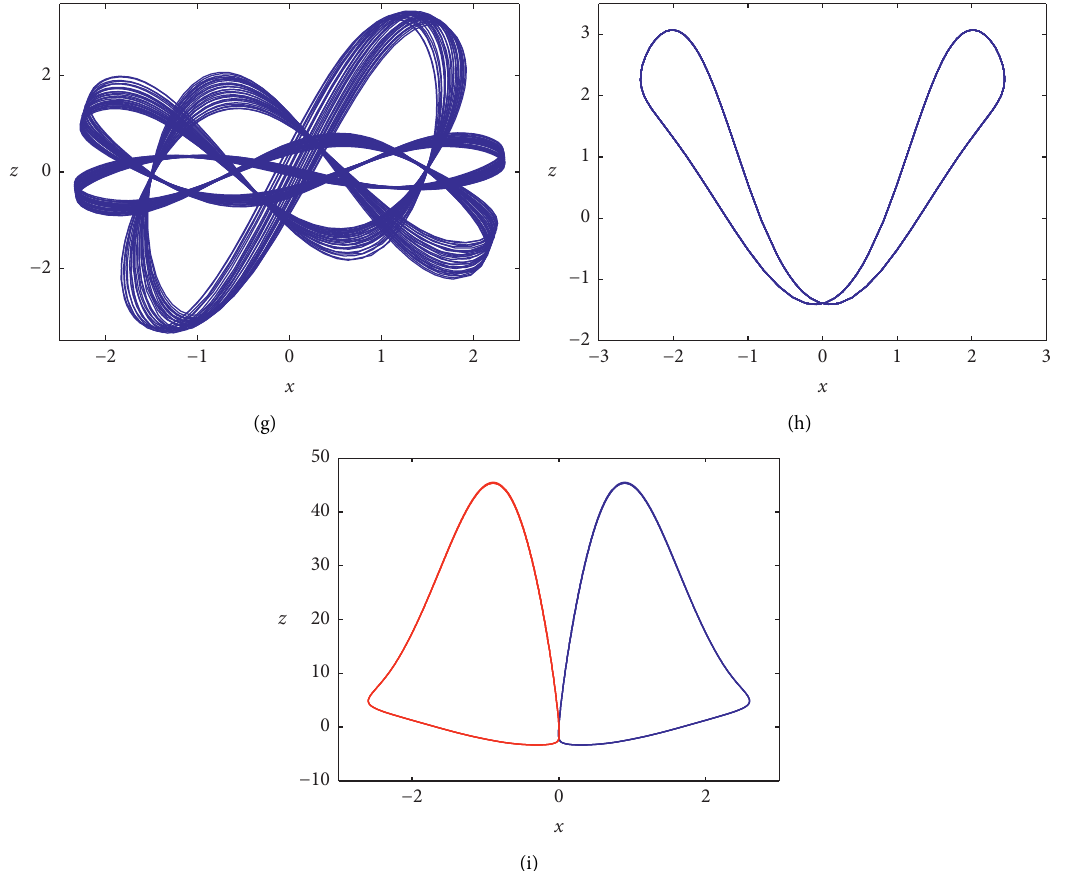
Figure 2: Chaotic flows from system (1) at various values of a and b . (a) a � − 5, b � 0. (b) a �− 4, b � 0. (c) a �− 0.8, b � 0. (d) a � − 0.5, b � 0. (e) a � − 0.2, b � 0. (f) a � − 0.15, b � 0. (g) a � − 6.17, b � − 1. (h) a � − 4.5, b � − 1. (i) a � − 0.8, b �−